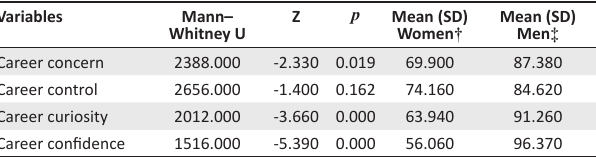
TABLE 3: Results of Mann–Whitney U test showing significant mean differences between women and men regarding career adaptability. Variables